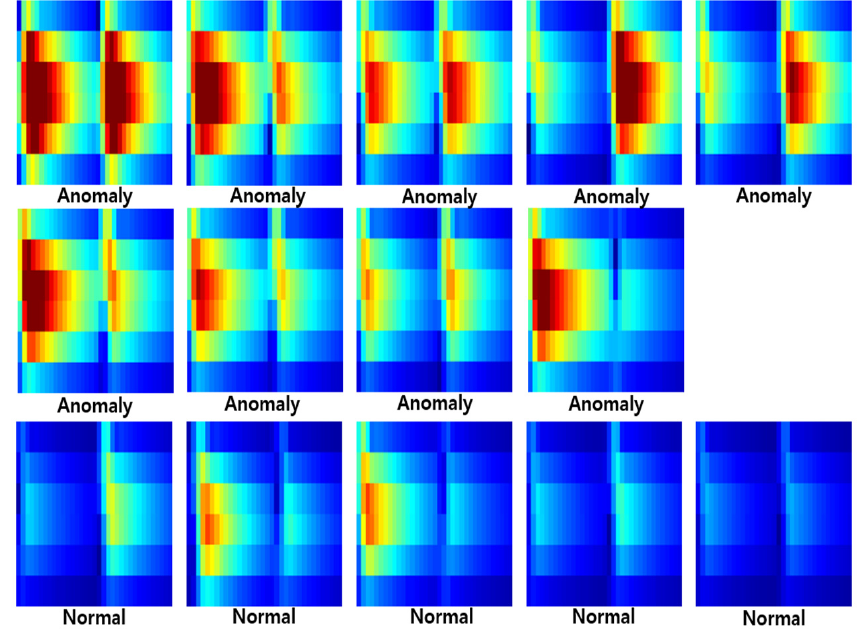
Figure 27. Samples of normal and abnormal data.